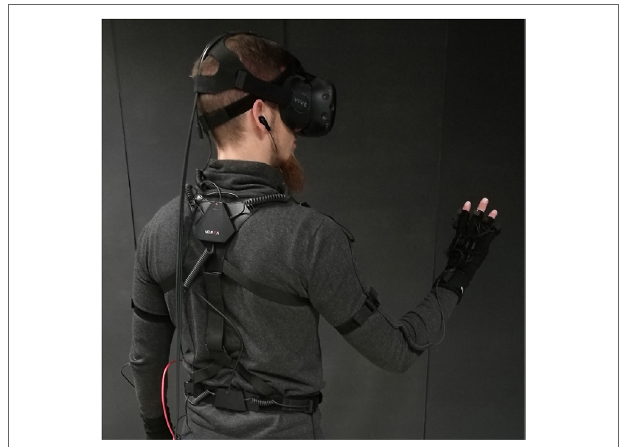
FigUre 4 | User equipped with the required devices for the experiment: HTC Vive virtual reality headset, Perception Neuron motion capture